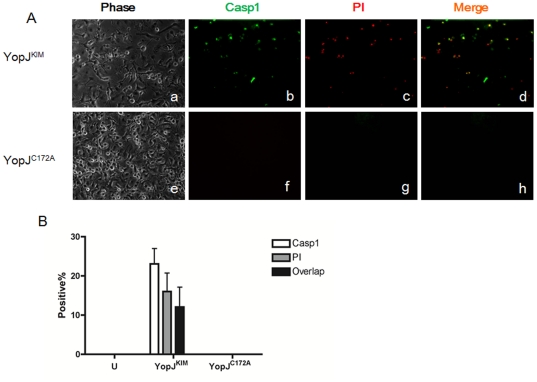
KIM5-infected necrotic macrophages contain active caspase-1.BMDMs were seeded on glass coverslips in a 24-well plate and left uninfected (U) or infected with Y. pestis strains expressing YopJKIM or YopJC172A. FAM-YVAD-FMK was added at 9 hr post infection to stain for active caspase-1 and PI uptake assay was performed immediately before microscopic analysis. (A) Representative images of phase, active caspase-1 (green) and PI uptake (red) signals captured by digital photomicroscopy are shown in a-c and e-g, respectively. Panels d and h show merged images of green and red signals. (B) Average percentages of BMDMs positive for active caspase-1, PI or both signals was calculated (∼100–300 cells per field) from three random fields in three independent experiments. Error bars represent standard deviations.